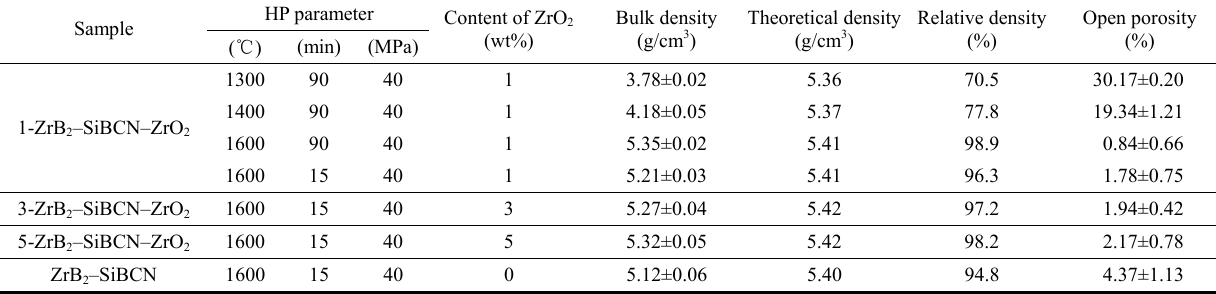
Table 1 Main hot-pressing parameters and physical properties of the obtained